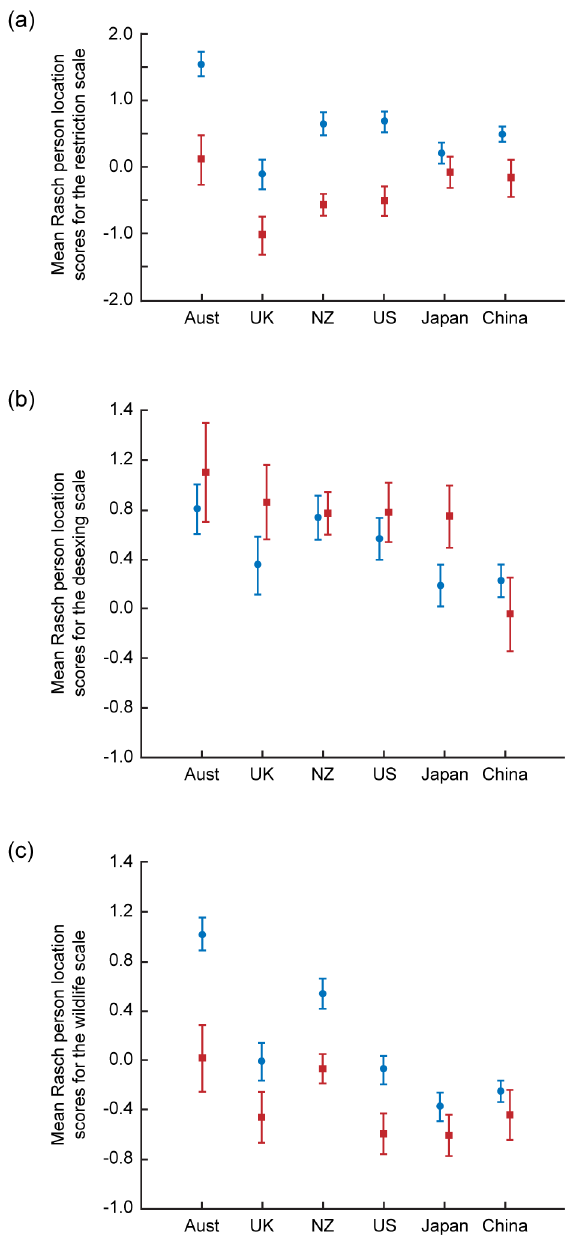
Fig 3. Mean Rasch person location scores, ± 95% confidence limits, for owners (red) and non-owners (blue) on (a) The restriction scale (b) The desexing scale (c) The wildlife scale.